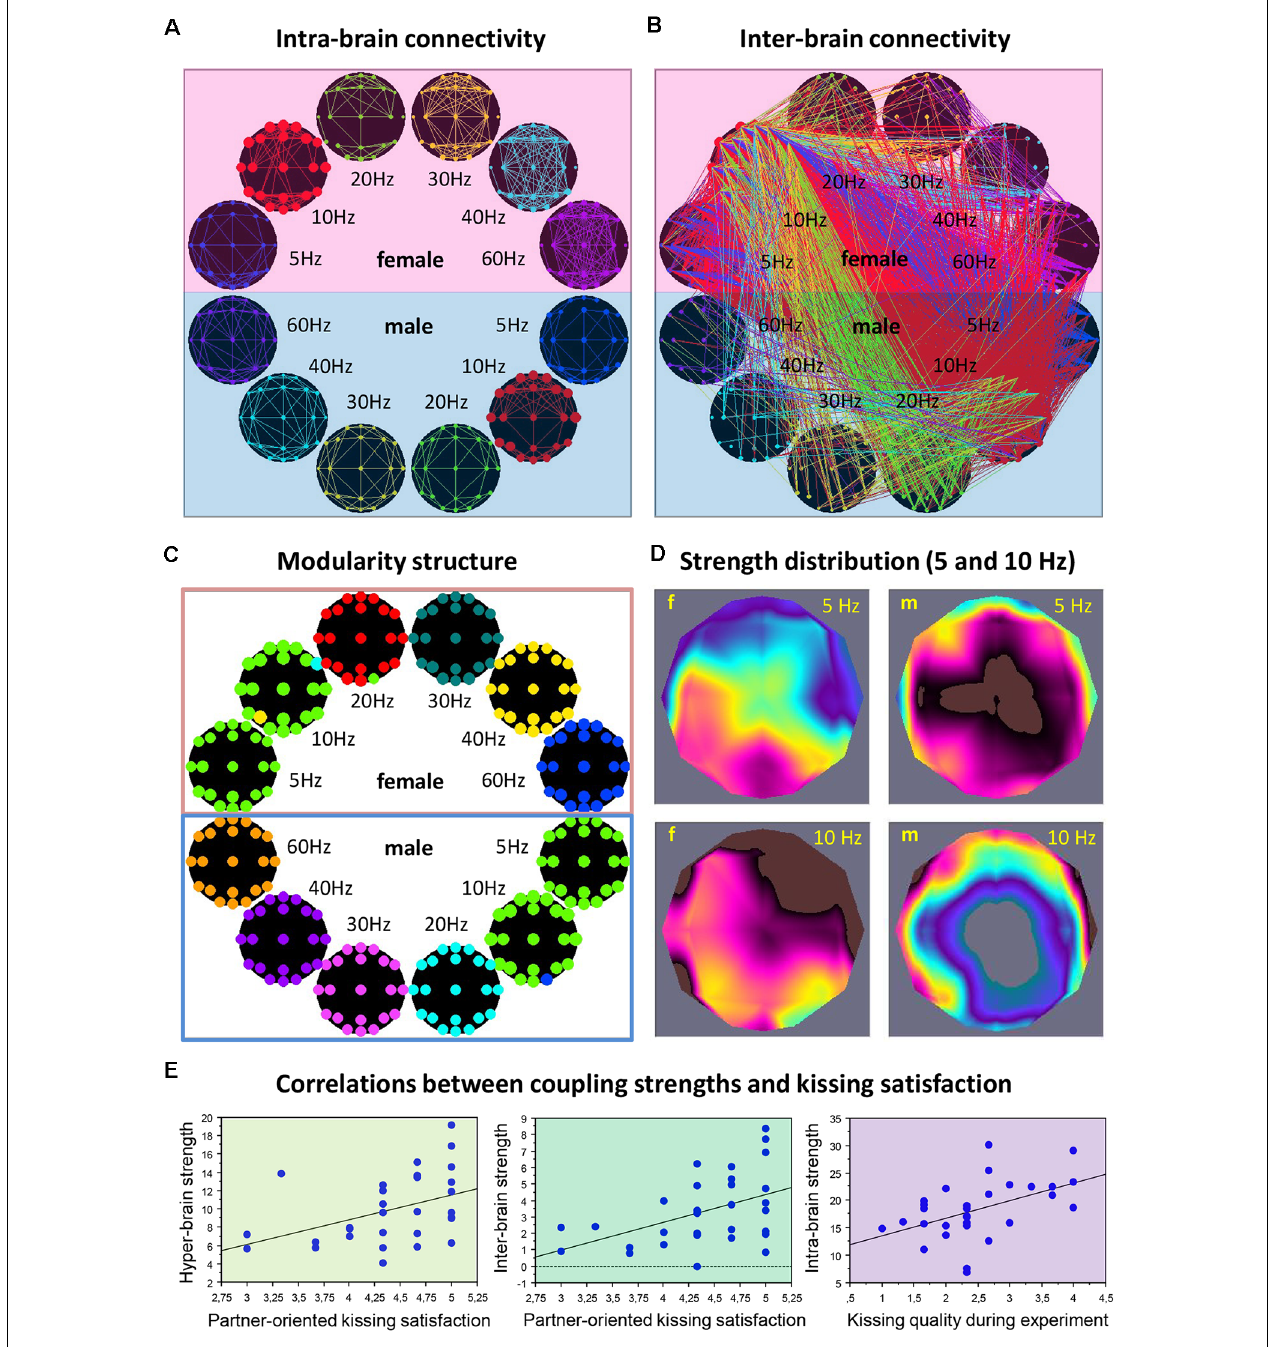
FIGURE 4 | Representation of the hyper-brain network and the theta-alpha subnetwork during kissing. (A) Intra-brain connectivity. The brain maps represent connectivity at six different frequencies within the female and male partners’ brains, respectively. (B) Intra-brain connectivity. The brain maps represent the between-brain connectivity within and between the six frequencies. It can be seen that the strongest connections are found in the theta (blue) and alpha (red) frequency bands, and between them. (C) Modularity structure. Modularity analysis revealed nine different modules. The biggest module is the so-called theta-alpha module or subnetwork comprising 5- and 10-Hz nodes in both female and male brains. Other modules represent different frequencies in both brains separately. (D) Out-strength distribution of theta (5 Hz) and alpha (10 Hz) nodes within the female and male brains. The topological distribution of coupling strength represents the overall within- and cross-frequency connectivity within the theta-alpha subnetwork for female and male brains, respectively. (E) Correlations between coupling strengths and kissing satisfaction and kissing quality. Partner-oriented kissing satisfaction correlated significantly positively with the hyper- and especially inter-brain strengths determined for 5-Hz oscillation nodes. Kissing quality during the experiment correlated significantly positively with intra-brain strength determined for 10-Hz oscillation nodes (adapted from Müller and Lindenberger, 2014 and Müller et al., 2021a).